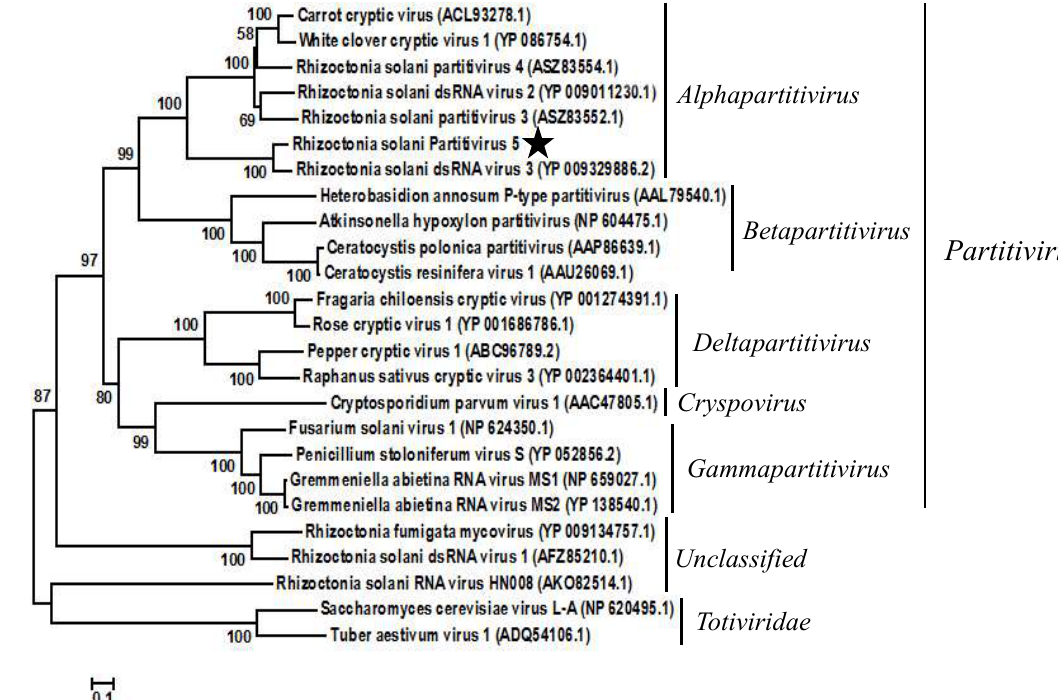
Figure 2. Phylogenetic analysis of RsPV5. A phylogenetic tree was generated for the putative amino acid sequences of the deduced RdRp proteins using the neighbor-joining method with the program MEGA 6.0 and Bootstrap 1000 replicates. The RdRp sequences were obtained from GenBank and the accession numbers of viruses are given in the brackets behind the virus names. The scale means a genetic distance of 0.1 amino acid substitutions per site. Viral lineages are marked based on their taxonomic